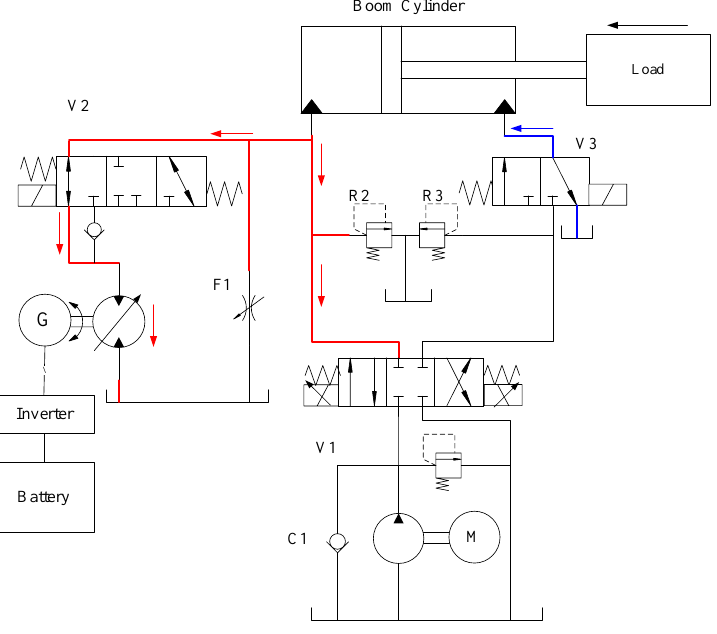
Figure 4. Boom-down operation in energy regeneration mode.